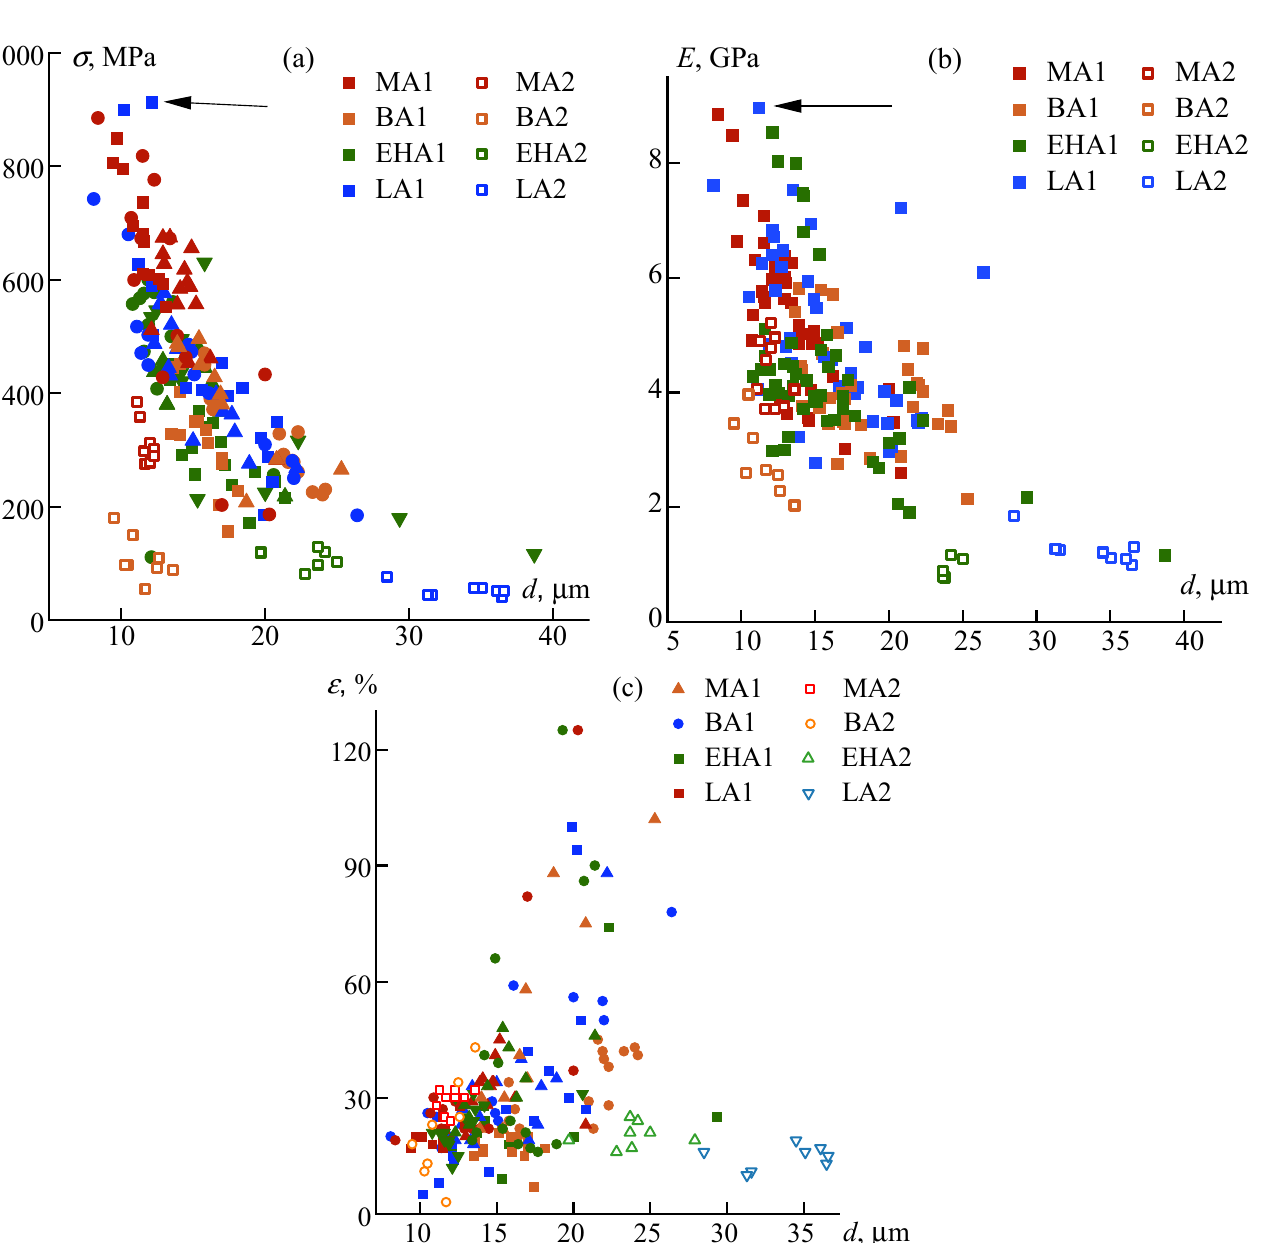
(b) Figure 10. Correlation of strength ( a ) and elastic modulus ( b ) of fiber with a molecular weight of